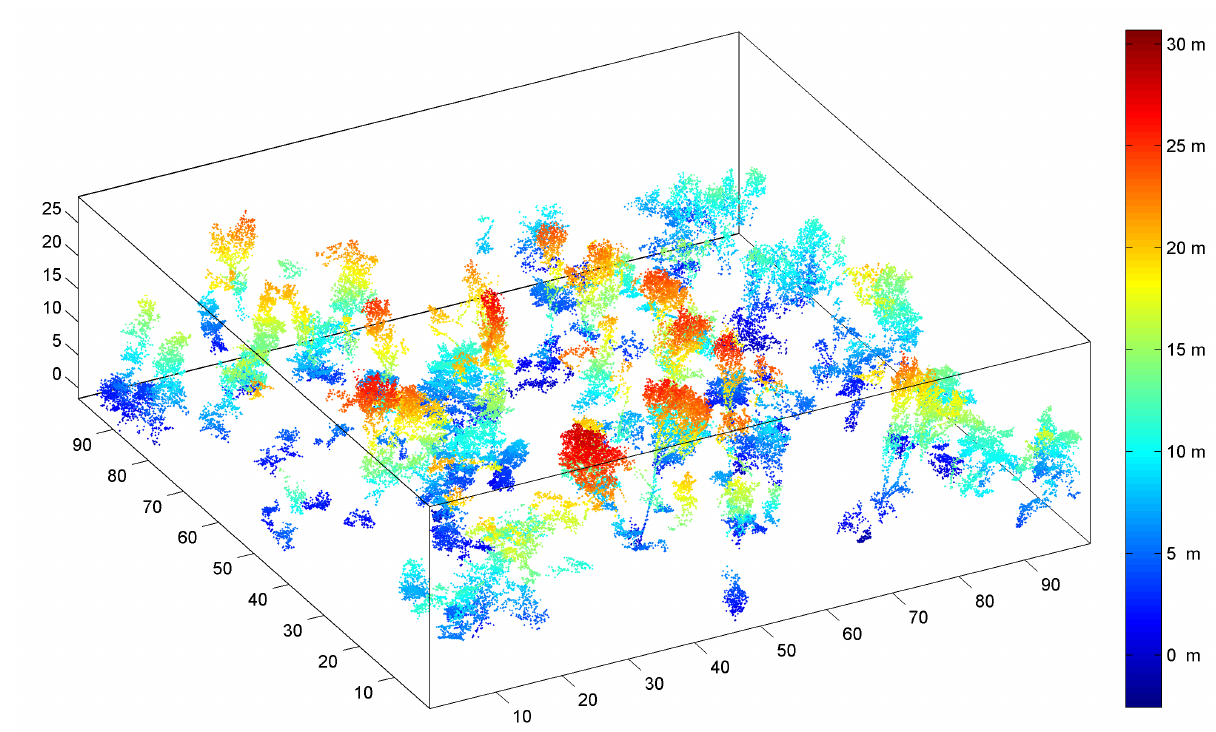
Figure 5: Resulting objects identified as change after region growing and removing of clusters smaller than 100 points. The points are coloured by their